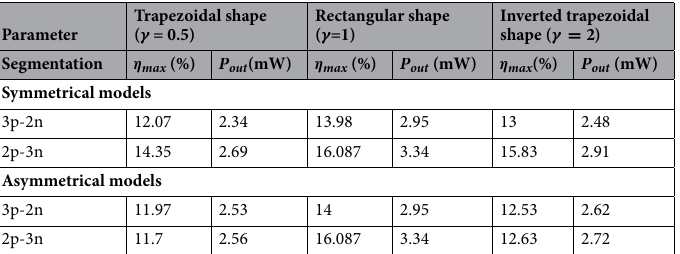
Table 2. Comparison of maximum efficiency and output power values at (cid:31) T = 600 K and R L = 5.83 (cid:31) for symmetric and asymmetric